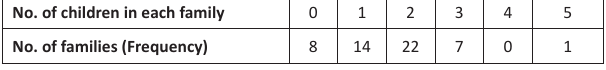
TABLE 1: Number of children in each family and their frequencies.